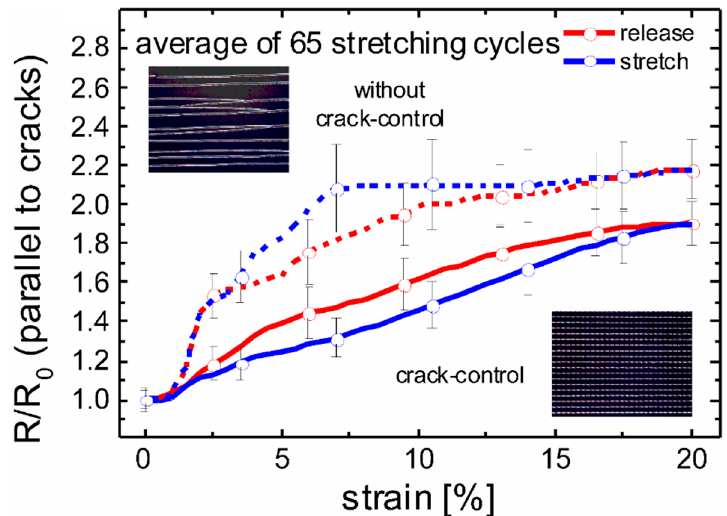
Figure 5. The change of the resistance in the direction parallel to the cracks during stretching perpendicular to the cracks; the two upper curves show the resistance change of a metal film without crack ‐ control. The two lower curves show that crack ‐ control results in a smaller resistance change under strain. The inset micrographs show the corresponding silver films after stretching. The length of the tested interconnects was about 7 mm.